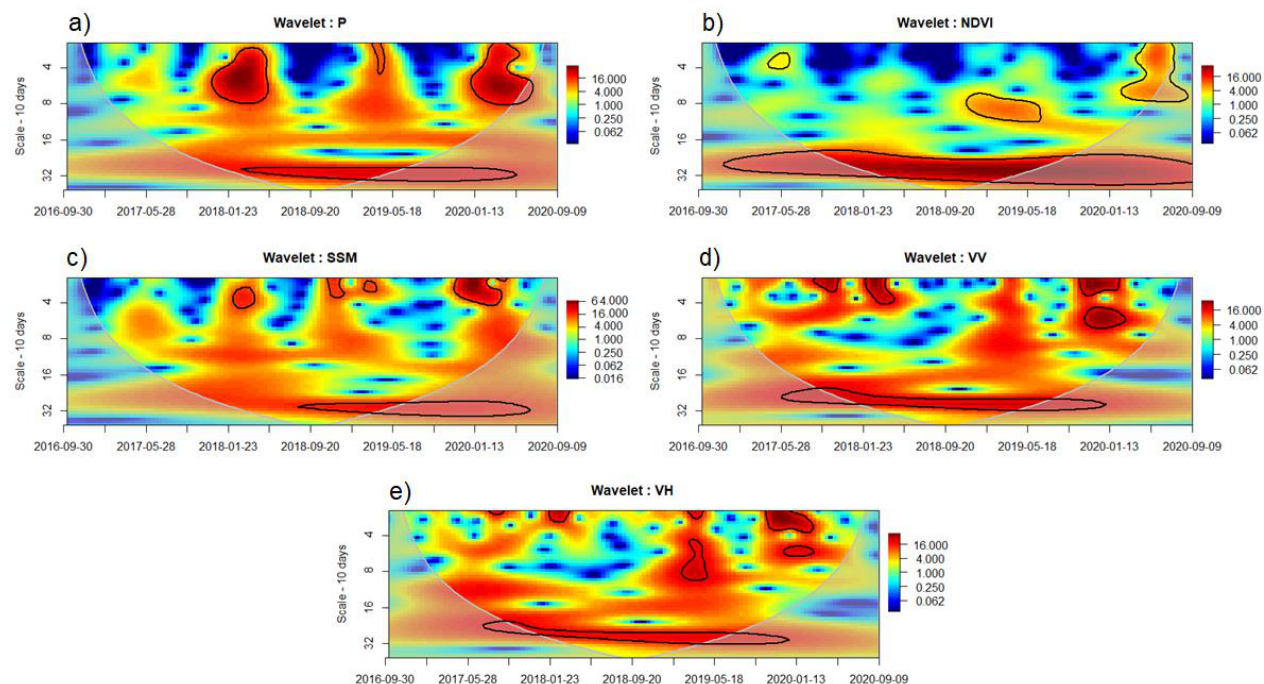
Figure 12. Continuous wavelet transformation (CWT): ( a ) daily precipitation (P); ( b ) normalized difference vegetation index (NDVI); ( c ) surface soil moisture (SSM); ( d ) VV polarization; ( e ) VH polarization. Notes: time is displayed on the horizontal axis, frequency on the vertical axis; warmer colors (red) represent high power signals, and colder colors (blue) represent low power; power scale bars are shown to the right of the charts; the thick contour indicates the 95% significance level against white noise; the cone of influence (COI) is shaded.